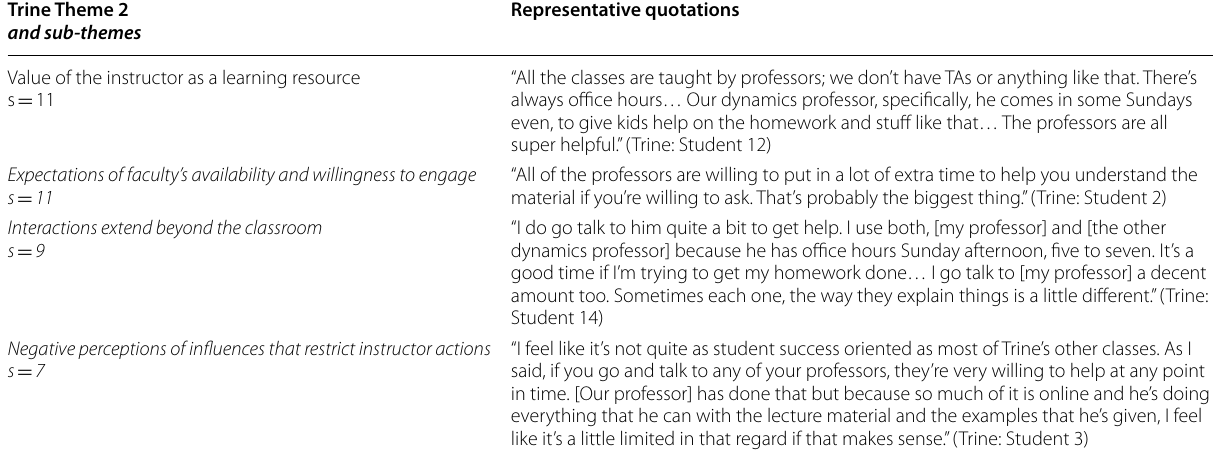
Table 9 Trine institutional analysis—Theme 2 Trine Theme 2 and sub-themes